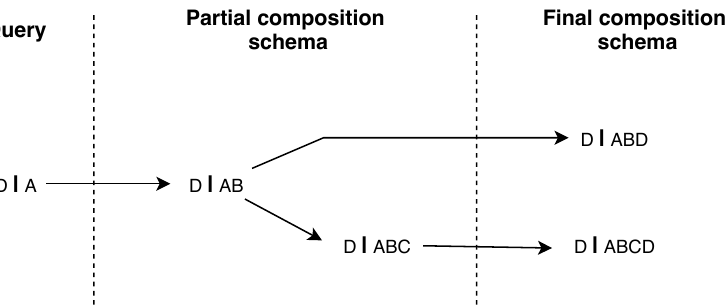
Figure 2. Composition schema: a sequence of property names representing the composition